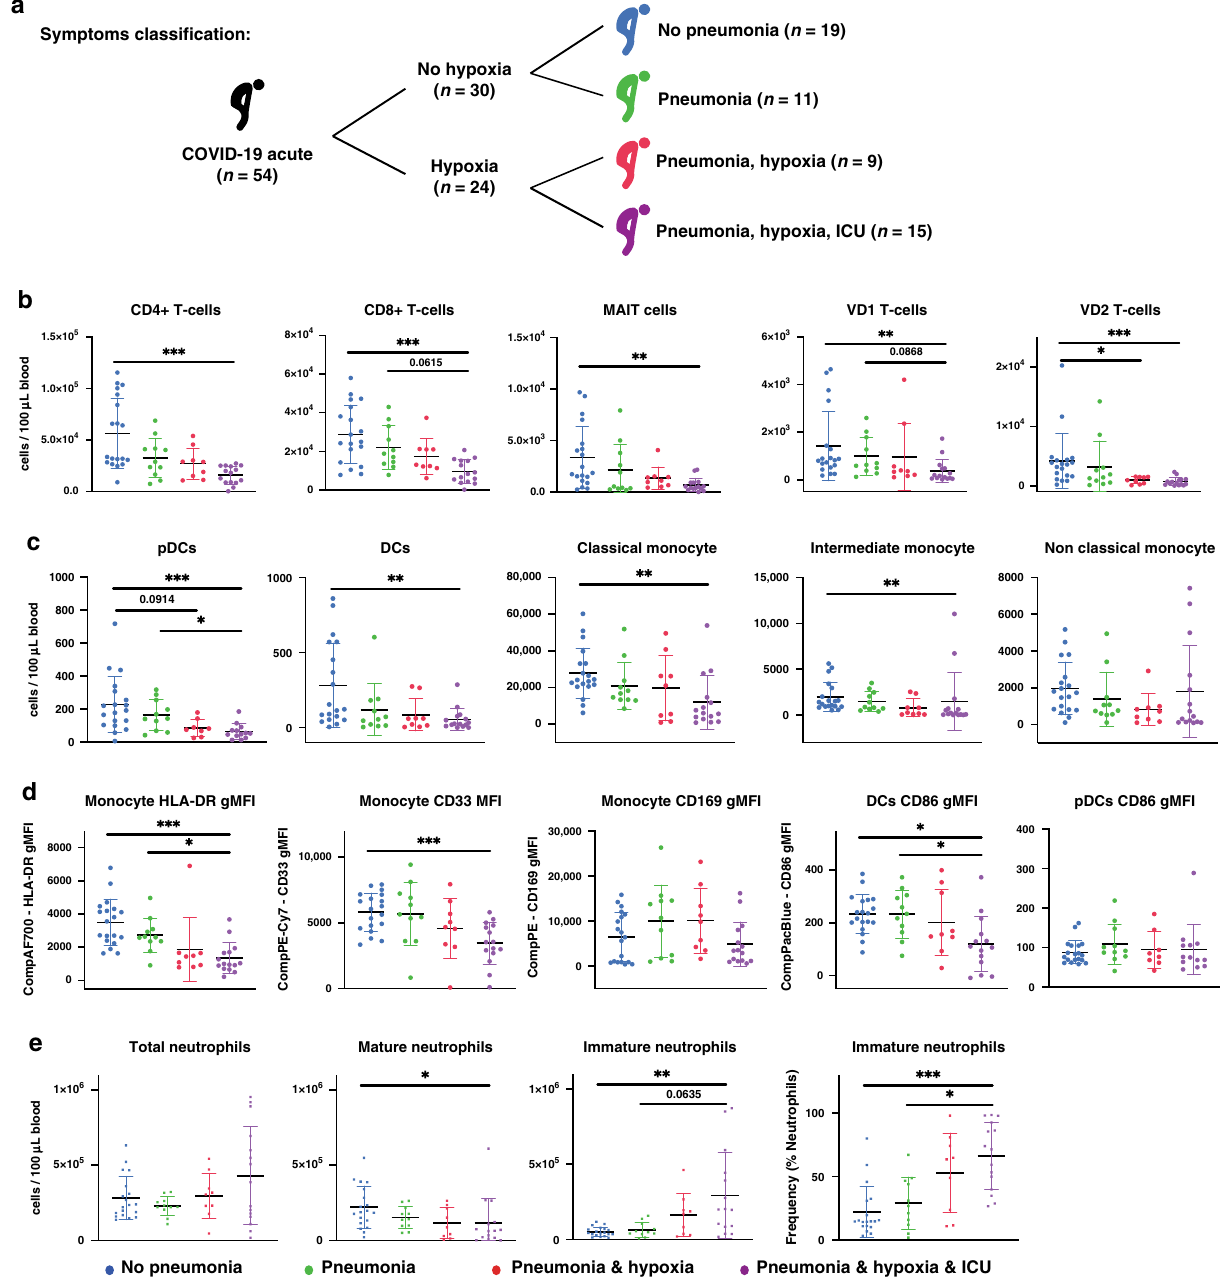
Fig. 3 Patient symptoms are re fl ected in immune cell variations. a Schematic representation of clinical symptoms in the patient cohort. b Absolute counts of T-cells across the severity. c Absolute counts of antigen presenting cells across the severity. d gMFI of activation markers on antigen presenting cells. e Absolute counts and frequency in neutrophil compartments. Data presented are from individual human acute COVID-19 patients n = 54 from panels a , b and c , separated according to clinical severity: no pneumonia n = 19, pneumonia no hypoxia n = 11, pneumonia with hypoxia no ICU n = 9, pneumonia with hypoxia with ICU n = 15. Scatter dot plots are presented with mean ± SD. Absolute counts and frequency were analysed by Kruskal – Wallis with Dunn multiple testing correction, gMFI was analysed by Brown – Forsythe and Welch ANOVA with Dunnett T3 multiple testing correction. * p < 0.05, ** p < 0.01, *** p < 0.001. Data available in source data fi le, exact p -values are given in Supplementary Data